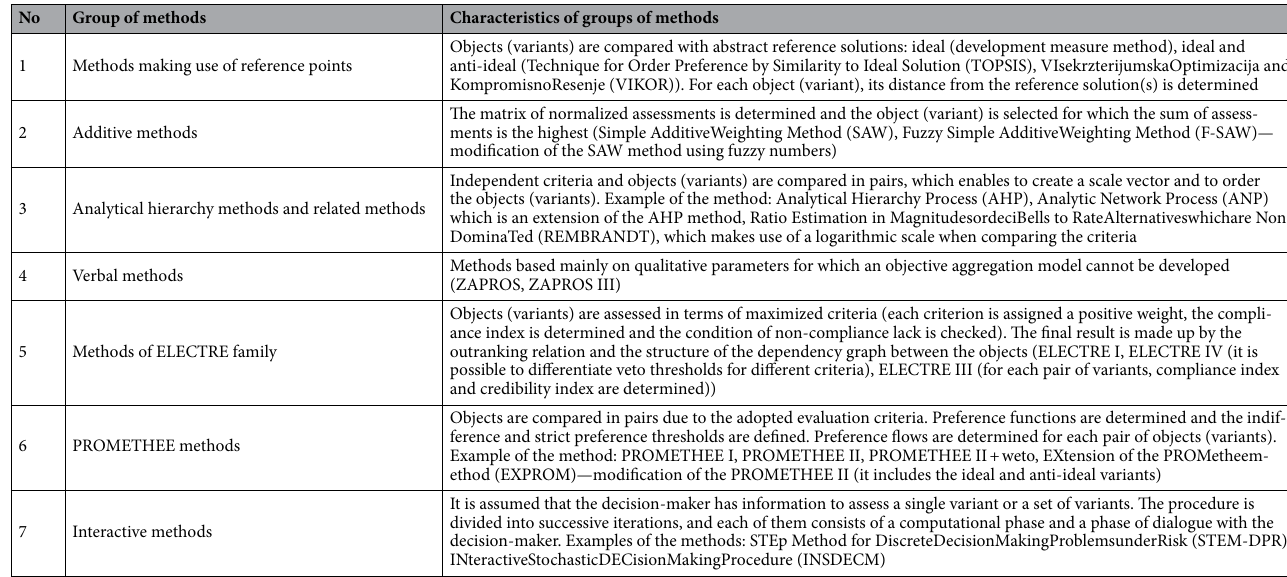
Table 1. Overview of selected groups of methods for solving multi-attribute decision-making problems 30,31